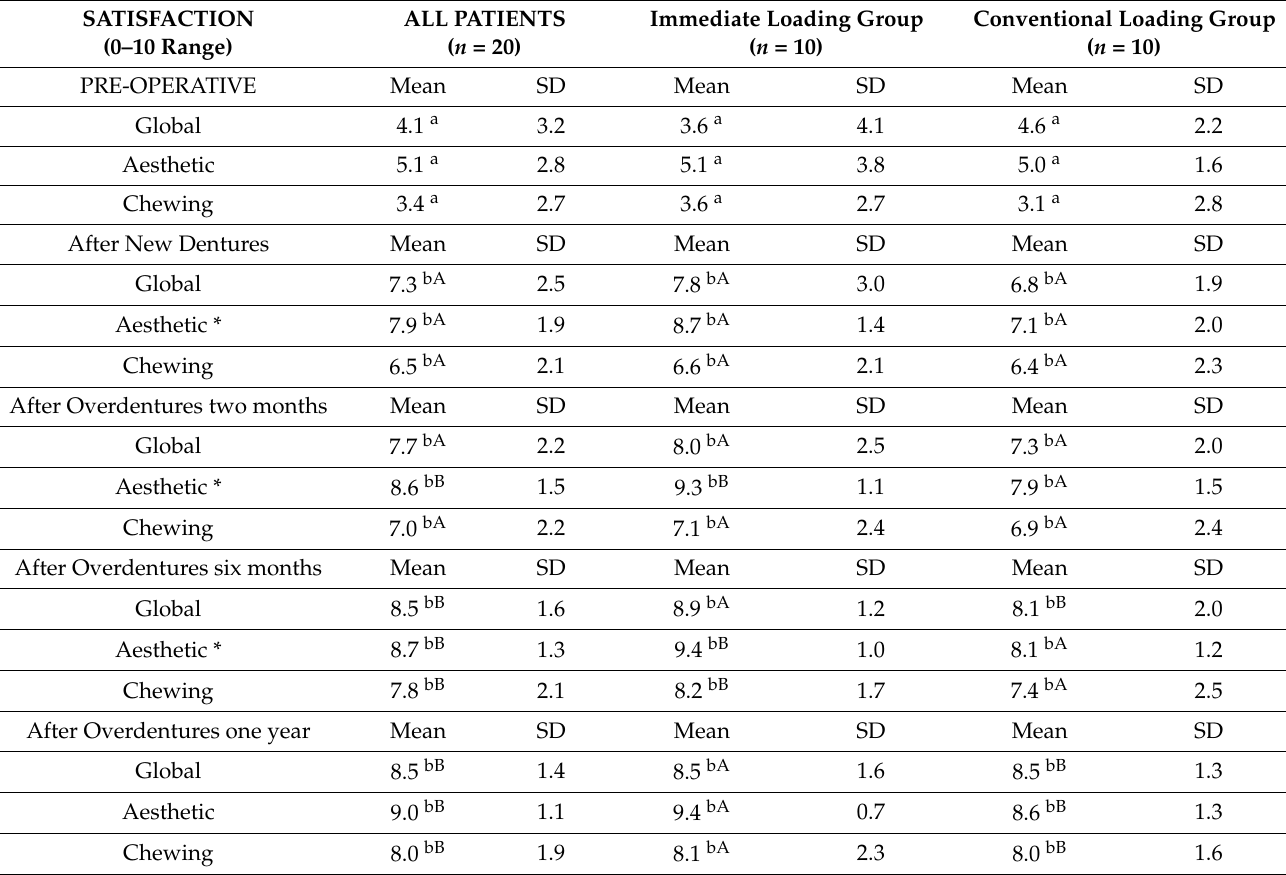
Table 7. Changes in self-rated chewing, aesthetic, and global satisfaction in a 0–10 scale after prosthetic treatments ( n = 20). SATISFACTION